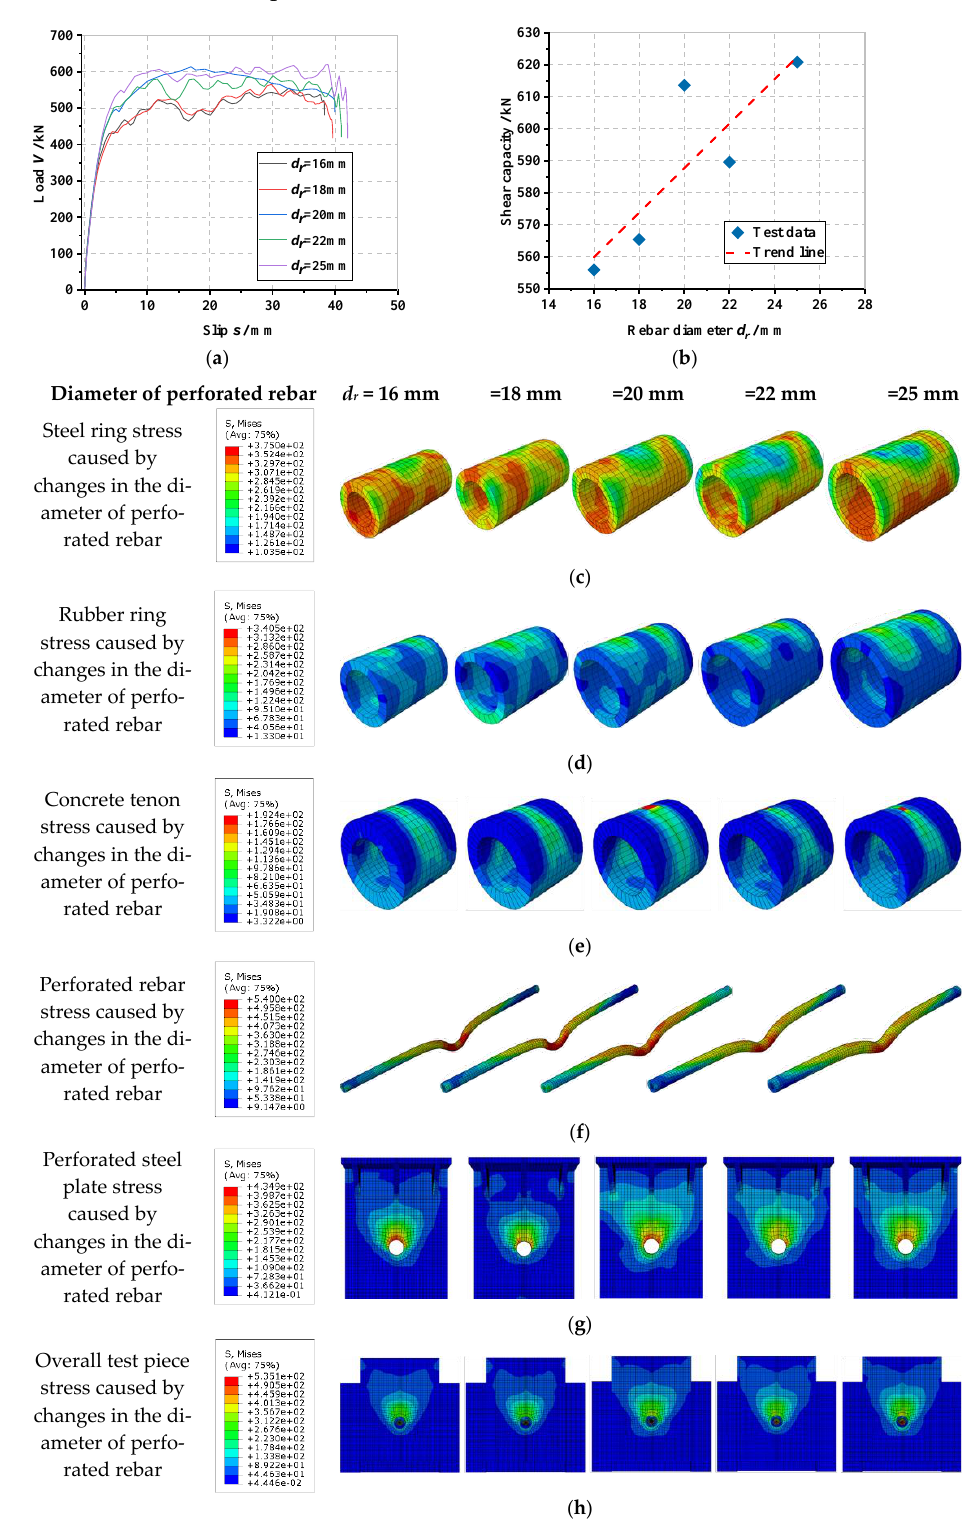
Figure 12. Influence of perforated rebar diameter: ( a ) overall load – slip curves, ( b ) impact analysis, ( c ) steel ring stress, ( d ) rubber ring stress, ( e ) concrete tenon stress, ( f ) perforated rebar stress, ( g ) perforated steel plate stress, ( h ) overall stress in the specimen.